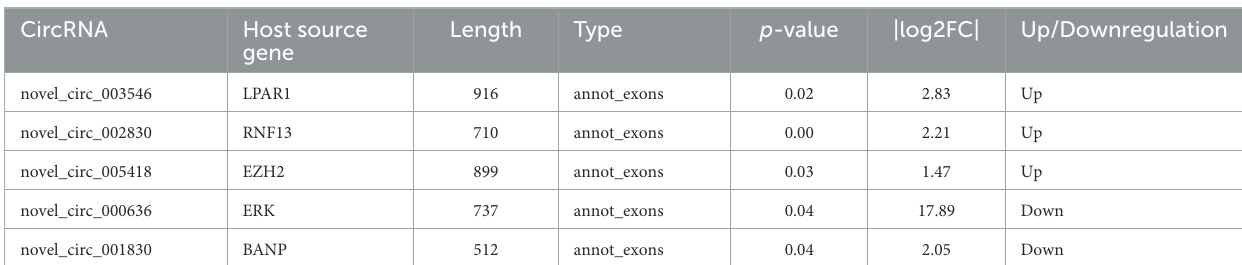
TABLE 3 CircRNAs selected for expression